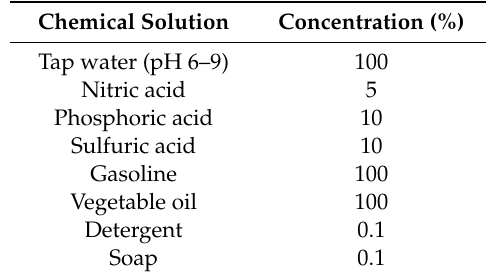
ASTM F1216 [11] minimum chemical resistance requirements for domestic sanitary sewer